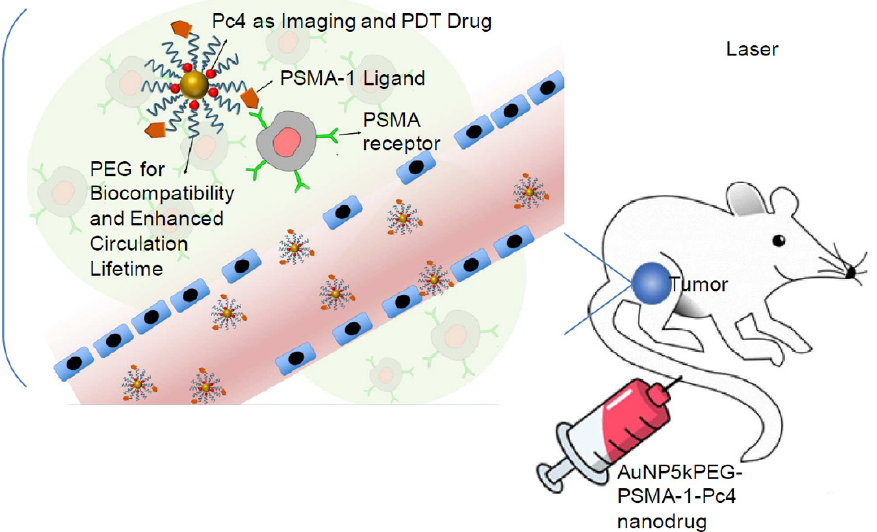
Figure 9. PDT of prostate cancer using AuNPs in a mouse model. Graphical illustration of AuNPs carrying the prostate-specific membrane antigen [191]. Copyright American Chemical Society 2018.